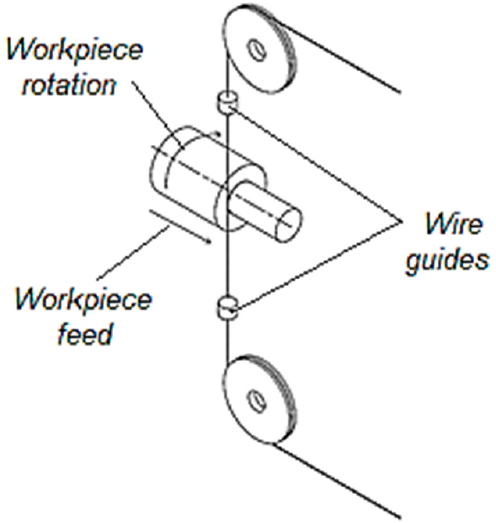
Figure 5. Redrawn figure of the of wire electrical discharge turning (WEDT) process (ref. [36]).